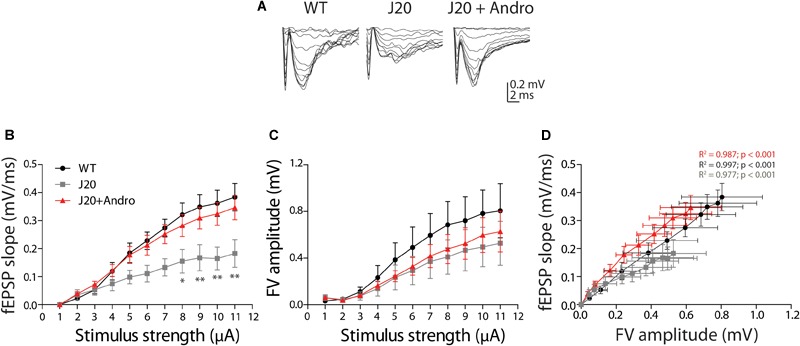
Input–output curves showing reduced basal synaptic transmission in J20 Tg mice. Representative fEPSPs (A) evoked in response to successive increments of current intensity (from 1 to 11 μA), in WT (black dots), J20 (gray squares) and J20+ANDRO (red triangles). Input–output curves of fEPSP slope (B) and FV amplitude (C), both against stimulus intensity, demonstrating deficient synaptic transmission. Linear regression plot of fEPSP slopes dependence on FV amplitude (D), evidenced that Tg animals cannot sustain responses with high stimulation. In B, WT vs. J20+ANDRO are significantly different from J20 [two-way repeated measures ANOVA: interaction: F(20,220) = 1.63, p > 0.05; animal group factor: F(2,220) = 29.35, p < 0.001; stimulation intensity: F(10,220) = 30.61, p < 0.001, followed by Bonferroni post hoc test: WT vs. J20 at 8 μA ∗p < 0.05, 9 to 11 μA ∗∗p < 0.01; J20 vs. J20+Andro at 8 μA ∗p < 0.05, 9 to 11 μA ∗∗p < 0.01; WT vs. J20+Andro p = n.s.]. In panel (D), the data were fitted with a linear regression: R2 = 0.99, 0.98, and 0.99 correspondingly; and slopes for WT = 0.459 ± 0.008; J20 = 0.3125 ± 0.016; J20+ANDRO = 0.530 ± 0.021. ANCOVA analysis between WT and J20: F(1,19) = 12.51, p = 0.002; WT and J2+ANDRO: F(1,19) = 49.87, p < 0.001; and J20 and J20+ANDRO = F(1,19) = 37.64, p < 0.001, gave significant differences among all linear regressions.